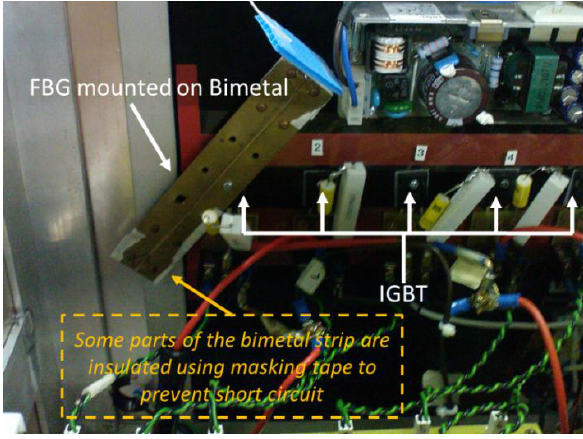
Figure 4. FBG-Bimetal temperature sensor screwed on top of an IGBT.